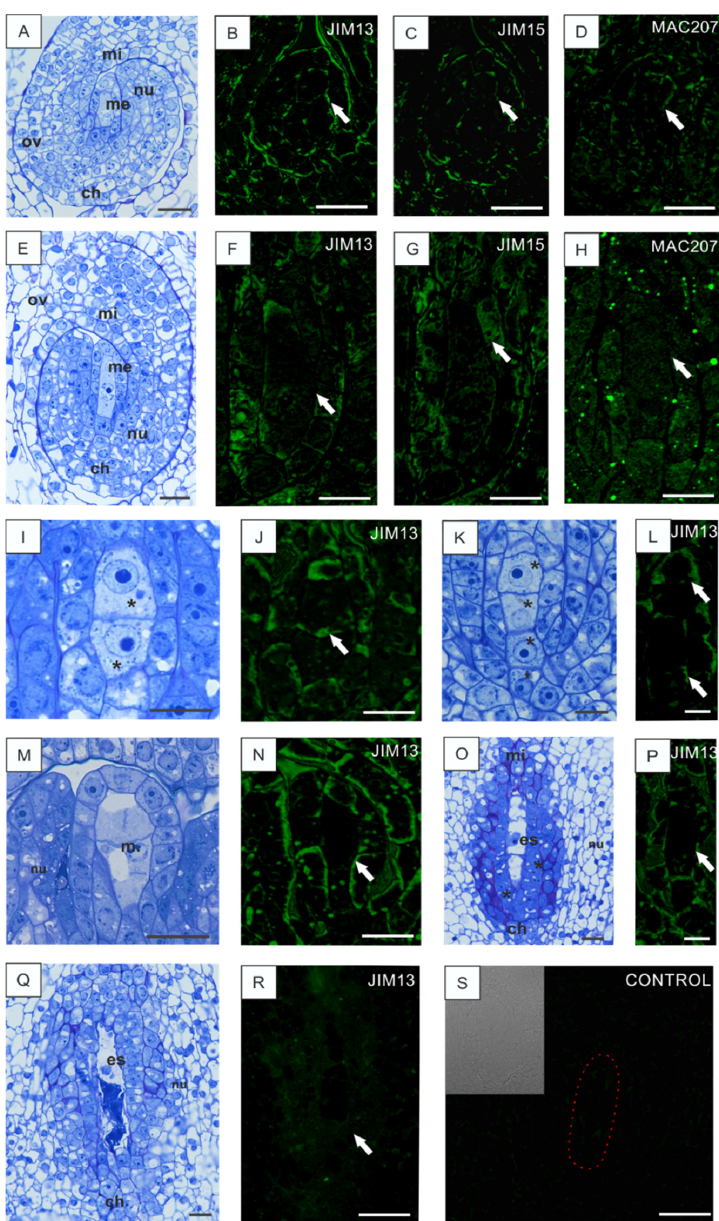
Figure 3. AGP localization in B. perennis ovules with disturbances in development caused by low temperature. Early stage of megasporocyte development ( A ). AGPs in the cell walls of the ovule (arrow); reaction with JIM13 ( B ), JIM15 ( C ), and MAC207 ( D ). Ovule with a formed megasporocyte ( E ). Epitopes of AGPs in the cell walls of adjacent megasporocyte cells of the nucellus and not visible in cell walls and cytoplasm of the megasporocyte (arrow); reaction with JIM13 ( F ), JIM15 ( G ), and MAC207 ( H ). Dyad stage (asterisks) ( I ). AGPs in dyad walls (arrow); reaction with JIM13 ( J ). Linear tetrad of megaspores (asterisks) ( K ). AGPs in the walls of megaspores (arrows); weak reaction with JIM13 ( L ). Stages of megaspore ( M ) and embryo sac formation ( O ). AGPs in the walls of somatic nucellus tissue (arrow); reaction with JIM13 ( N , P ). Degenerated embryo sac ( Q ). Absence of a fluorescence signal in the degenerated embryo sac (arrow); reaction with JIM13 ( R ). Control reaction with a marked embryo sac ( S ). Toluidine blue staining: ( A , E , I , K , M , O , Q ). Immunolabeling: ( B – D , F – H , J , L , N , P , R , S ). Bars: 20 μ m ( A – H ), 10 μ m ( I – S ). Abbreviations: ch—chalazal pole, es—embryo sac, m—megaspore, me—megasporocyte, mi—micropylar pole, nu—nucellus, ov—ovary wall.